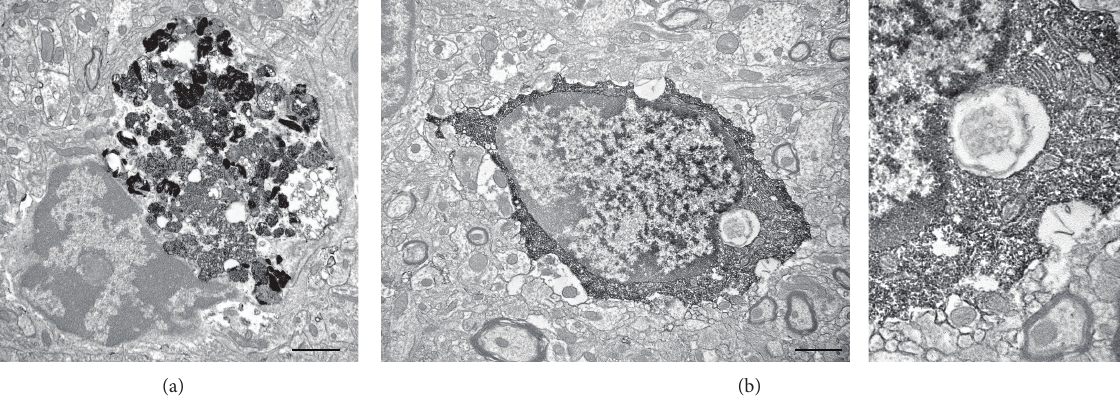
Figure 3: Microglial accumulation of phagocytic inclusions during aging and age-associated loss of sensory function. Examples of Iba1- immunostained microglia containing (a) accumulation of cellular inclusions from the phagocytic elimination of neurons or glial cells and (b) a single cellular inclusion that resembles an axonal terminal with clearly visible synaptic vesicles (inset) in the visual cortex of a 20-month-old mouse with age-associated loss of visual function. Scale bars: 1000nm. Reproduced from Tremblay et al.